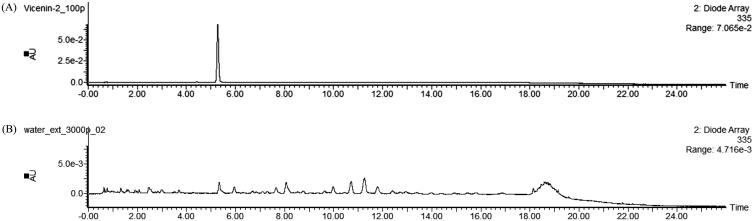
HPLC chromatogram for standard Vicenin-2 (A) and LCW (B). Both peaks have similar retention time of about 5.32 indicating that our LCW contains Vicenin-2.